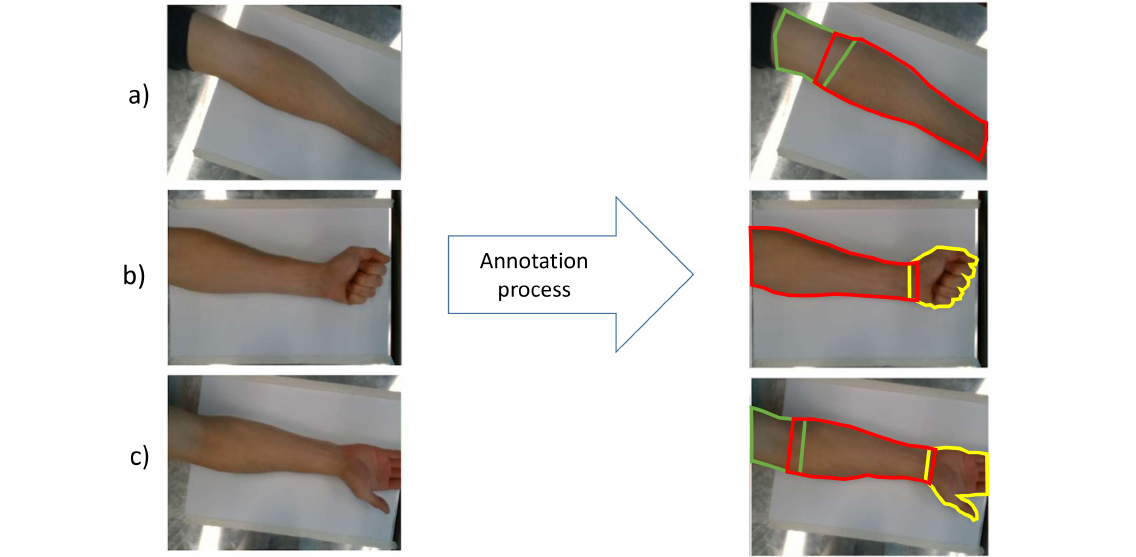
Figure 4. Annotation process for (a) forearm and hand, (b) forearm and upper arm and (c) all three